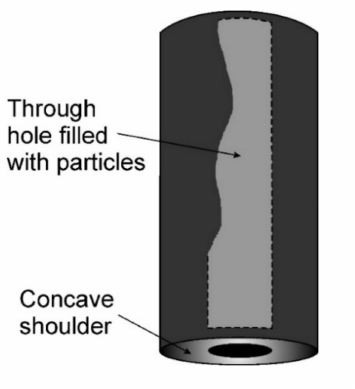
Figure 9. Direct friction stir-processing tool (authors’ own drawing).